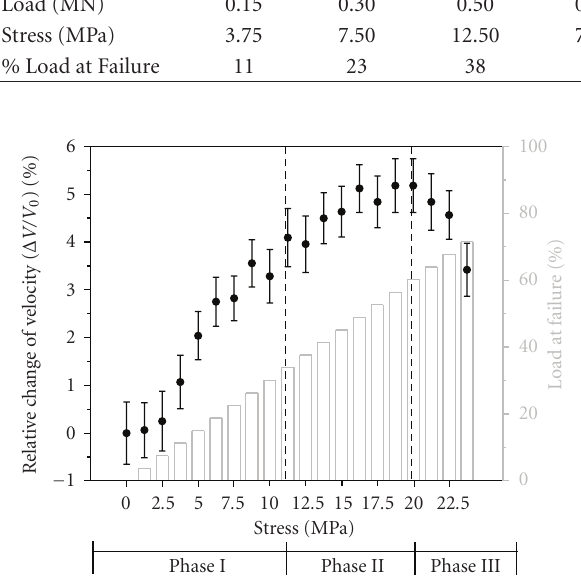
Figure 4: Surface wave velocity versus stress in the 8th load cycle. The velocities are normalized with respect to the velocity measured at the stress-free state of this load cycle. The bars indicate the percentage of load at failure at each load